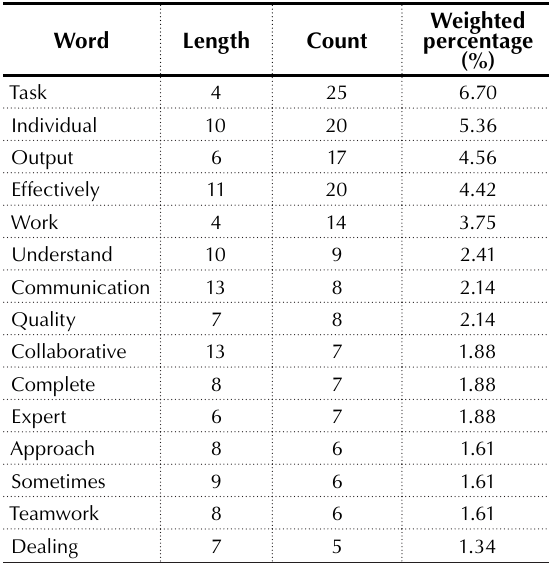
Table 5. Frequency analysis on transcripts